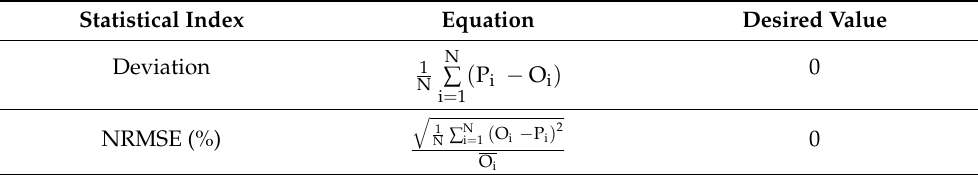
Table 3. Statistical indices used to evaluate model accuracy.